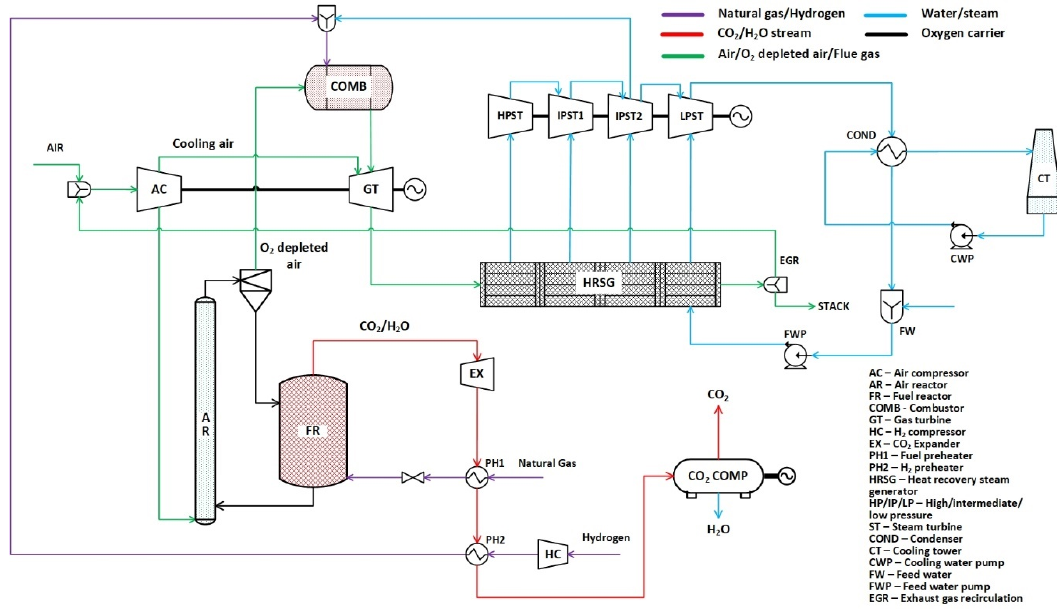
Figure 2. Schematic of CLC plant with an additional combustor [19].